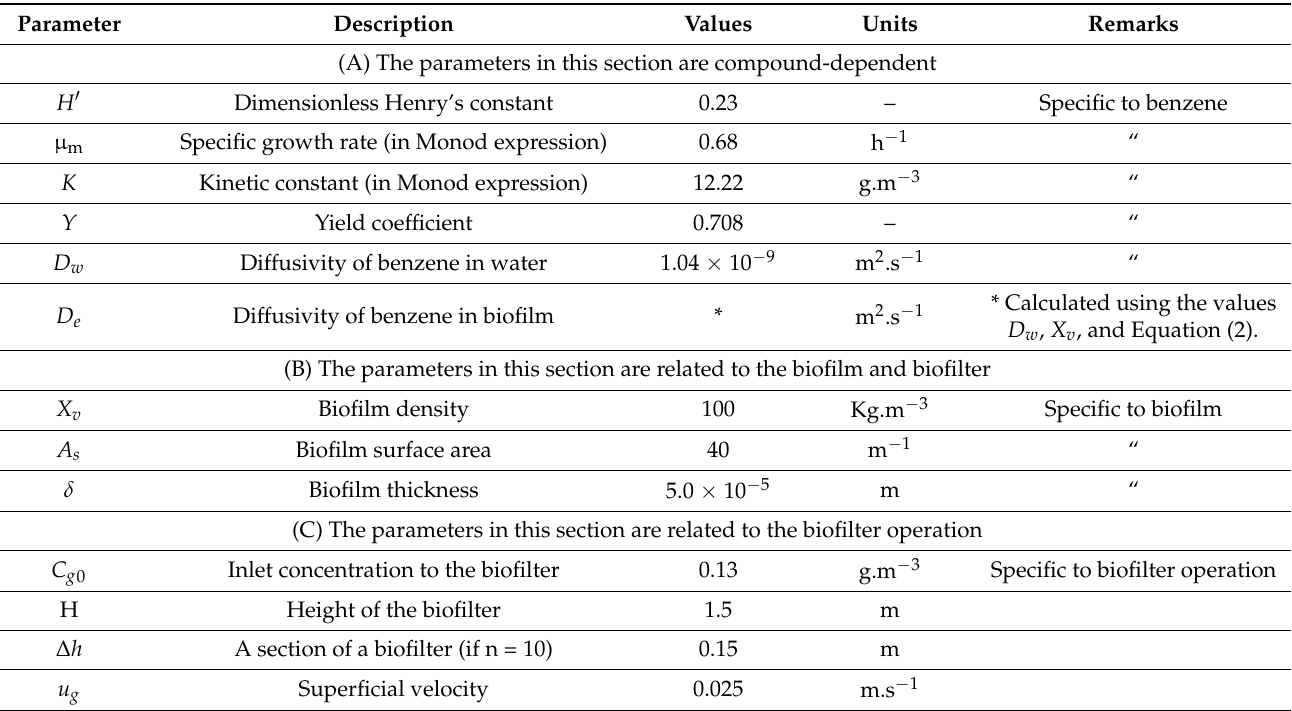
Table 1. Parameter values [6] used in the model